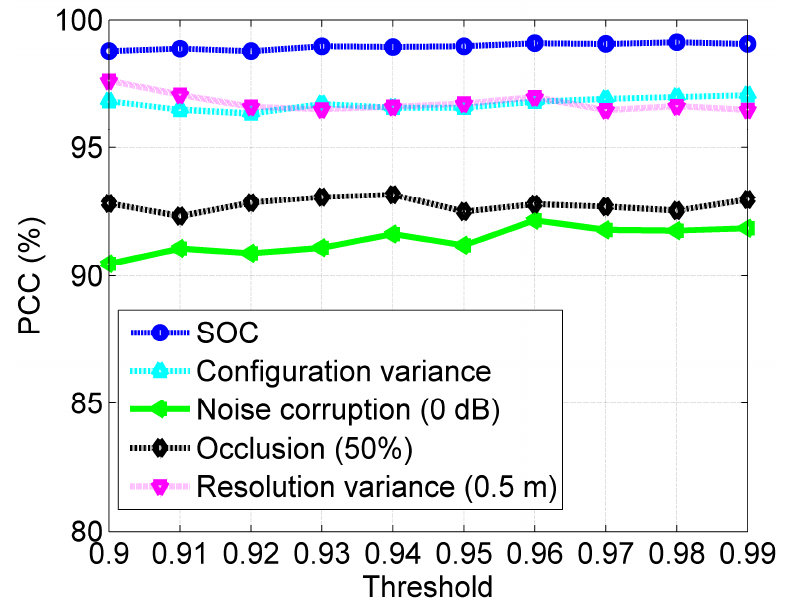
Figure 17. Performance of the proposed method at different thresholds